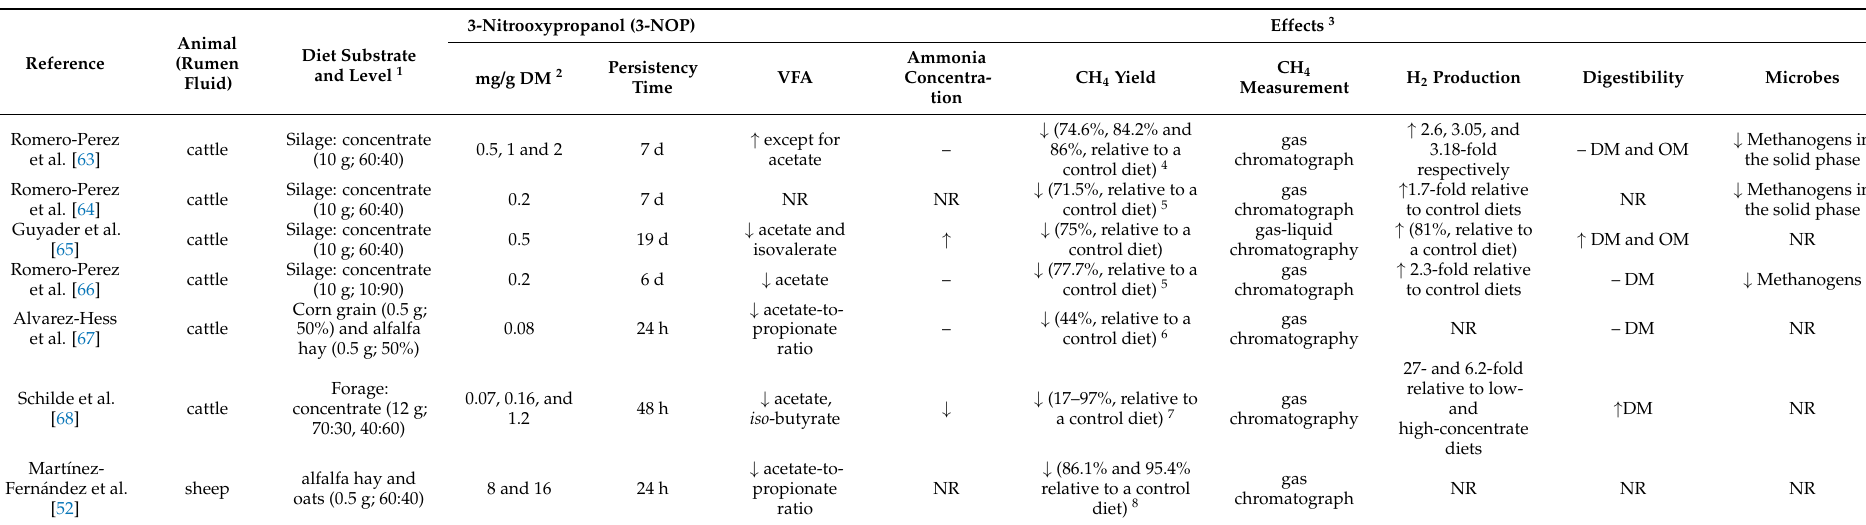
Table 3. Summary of 3-nitrooxypropanol (3-NOP) effects on in vitro fermentation, digestibility, microbes and enteric CH 4 production in